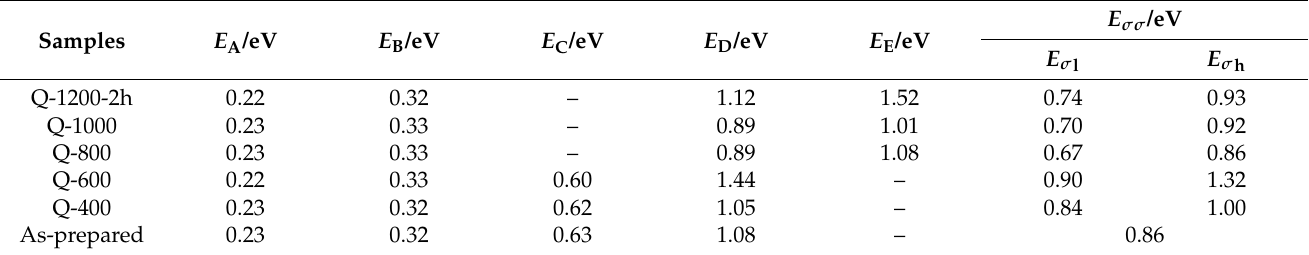
Figure 5. ε ”-spectra ZnO samples at low temperatures. ( a ) ε ”-spectra of the ZnO samples at − 100 ◦ C. ( b ) Effects of temperature on ε ”-spectra of Q-600 samples. ( c ) Arrhenius plots of peak frequencies of relaxations A and B on the measuring temperatures. ( d ) Time delay of magnitudes of relaxations A and B with the solid gray circles as the cooling temperatures. Table 3. Activation energies of dielectric relaxations and DC conduction of